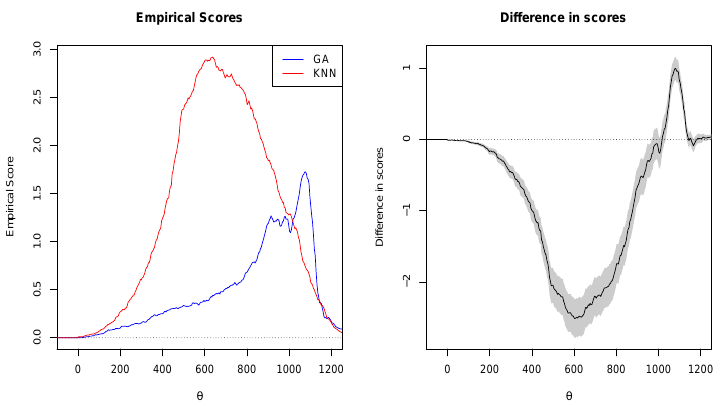
Figure 9. Plots of the GA and KNN forecasts showing the relationship between their empirical ( left panel ) and the differences in empirical scores with 95% confidence intervals ( right panel ).